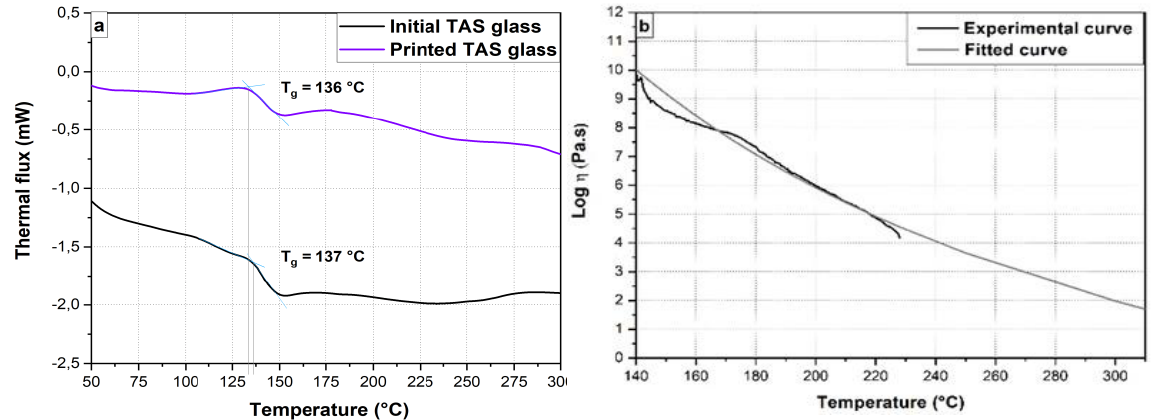
Figure 1. Thermal properties of the Te 20 AS 30 Se 50 (TAS) chalcogenide glasses: ( a ) differential scanning calorimetry measurement, ( b ) viscosity versus temperature curve.